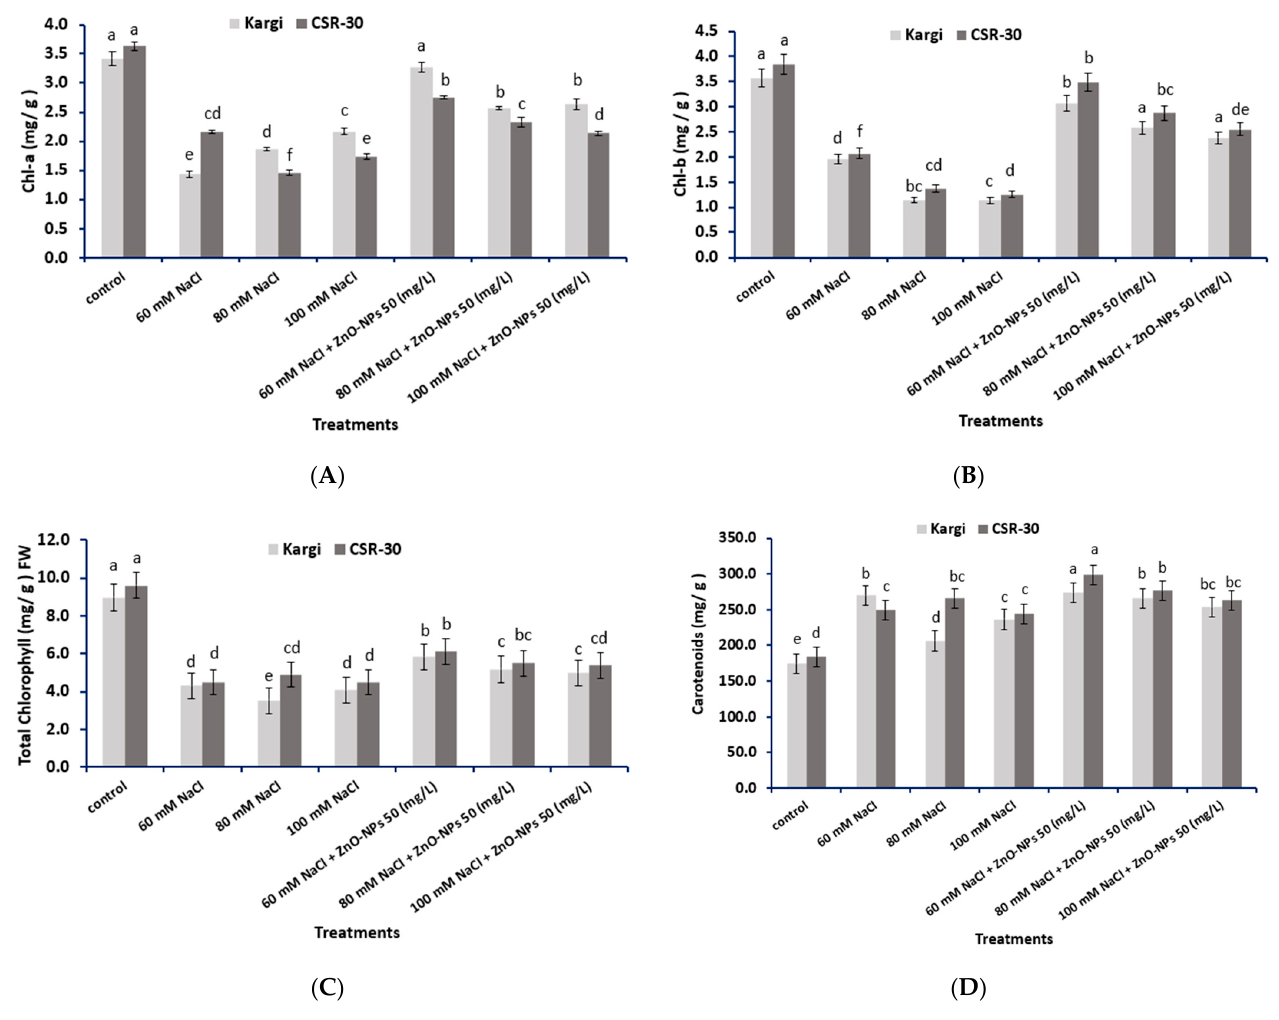
Figure 6. Impact of ZnO-NPs on photosynthetic pigments ( A ) Chl a, ( B ) Chl b, ( C ) total chlorophyll, and ( D ) carotenoids in leaves of Kargi and CSR 30 Oryza sativa genotypes in control and under saline conditions. Different small alphabets (a–f) indicate a statistically significant difference between treatments compared with control. Values are means of three replicates. Error bars indicate the least significant value (LSD) at p ≤ 0.01 among the treatments.